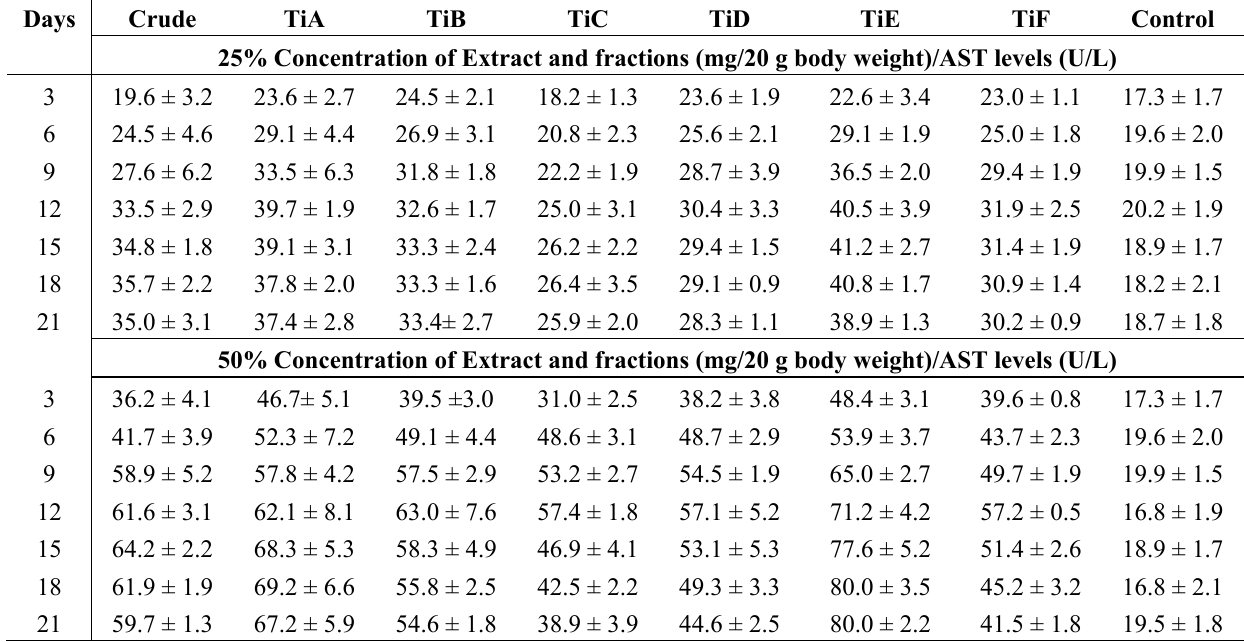
Table 8. Aspartate aminotransferase concentration at T . indica dosage over time.